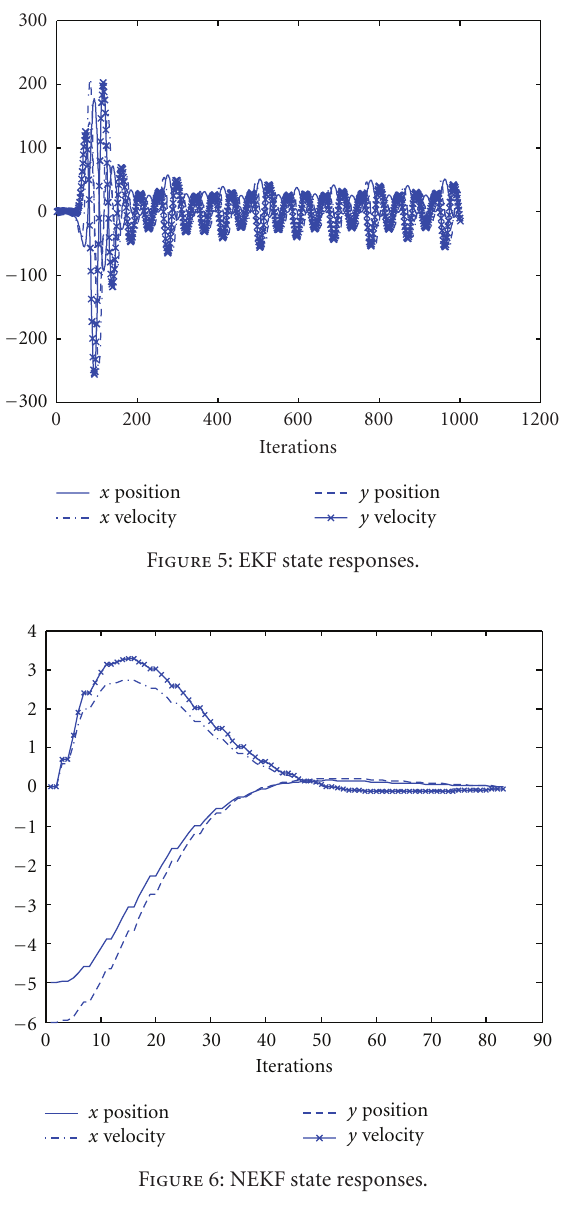
Figure 6: NEKF state responses.